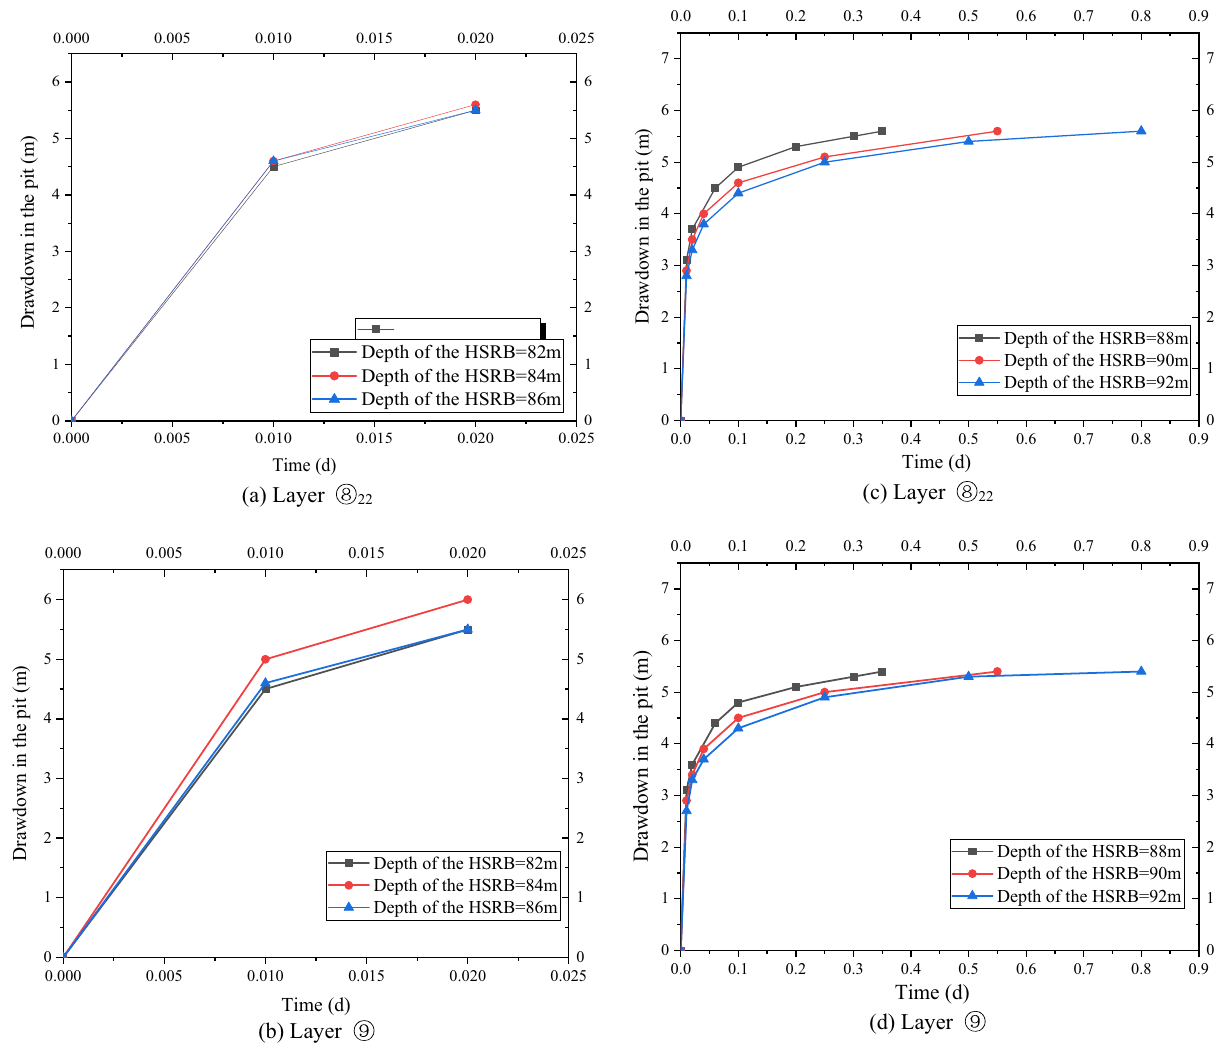
Figure 7. Drawdown–time curve in the pit with different HSRB